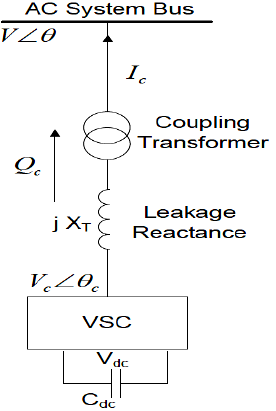
Figure 5. Schematic diagram of a STATCOM.